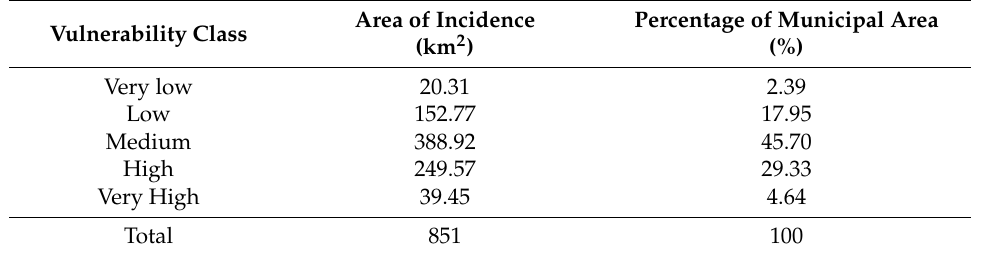
Figure 5. Flood vulnerability map of Batatais SP municipality. Table 5. Quantification of flood vulnerability areas within the municipality of Batatais SP, as function of vulnerability class. The spatial incidence of vulnerability classes is represented in Figure 5.